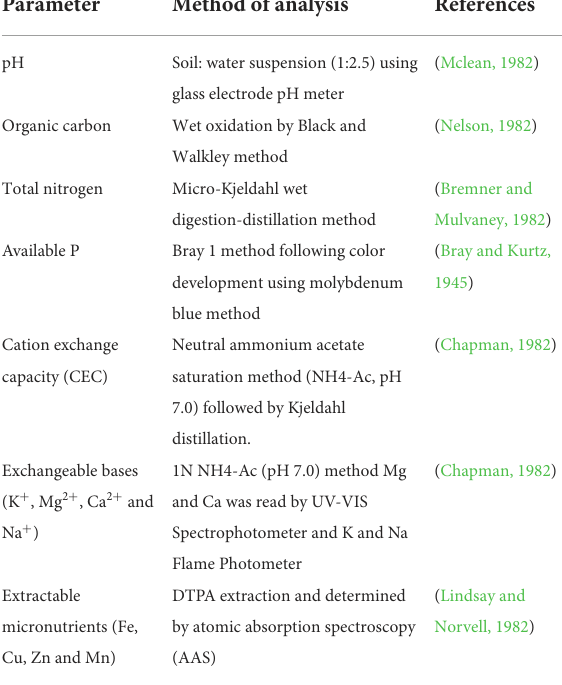
TABLE 2 Selected soil physical chemical properties. Parameter Method of analysis